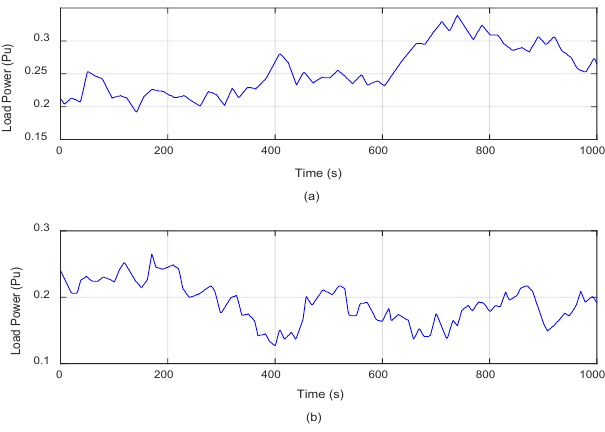
Figure 7. ( a ) Residential load pattern. ( b ) Industrial load pattern. Table 4. Multiple operating conditions of scenarios 2, 3, and Table 2. Initial parameters for WOA.